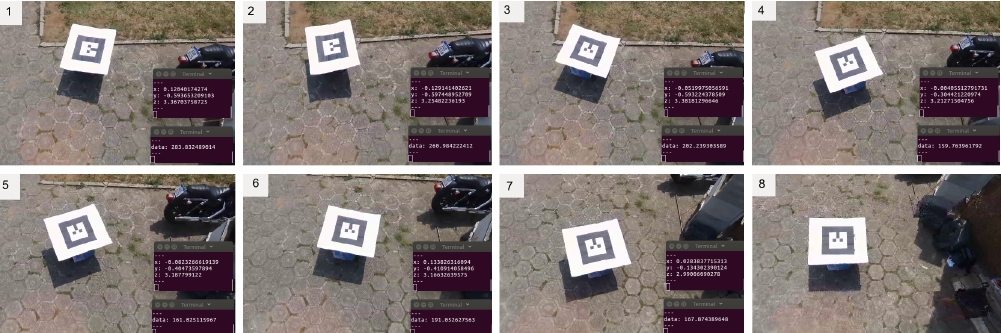
Figure 14. Snapshots of the UGV control displacement using AR-Tag position data in an outdoor site.